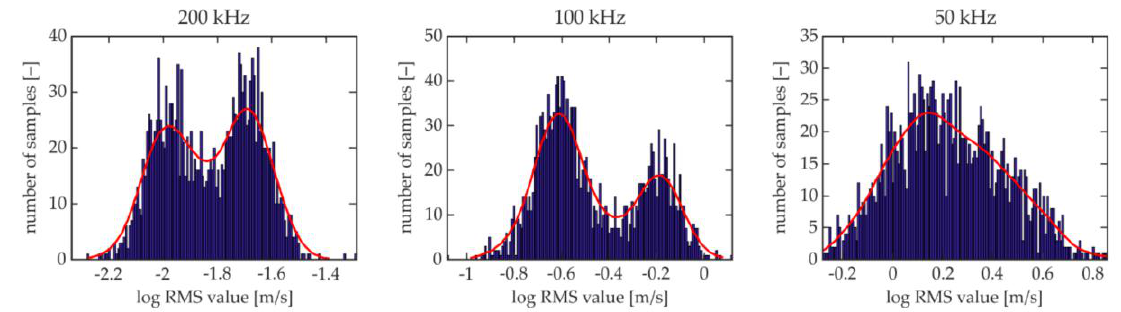
Figure 20. Histograms of WRMS values for specimen #6 with different excitation frequencies ( T = 3.00 ms, w r = r